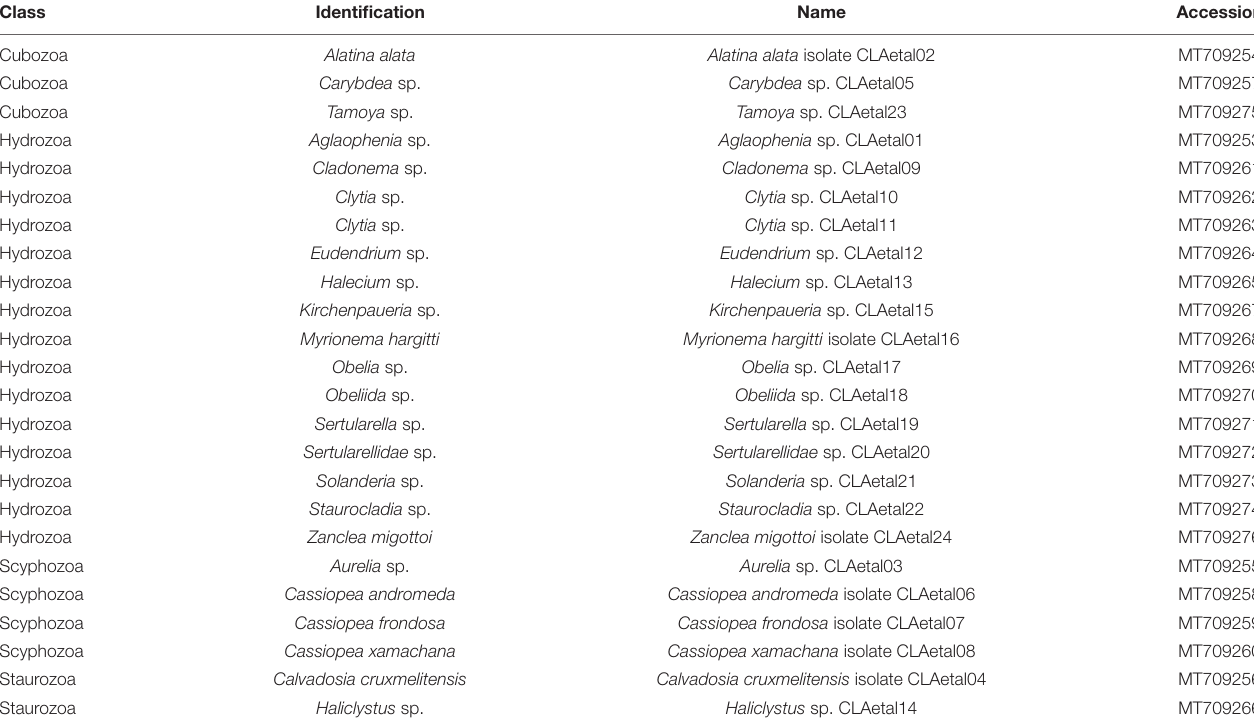
TABLE 2 | GenBank accession numbers corresponding to consensus sequences (16S rRNA gene) for medusozoan taxa detected as eDNA using